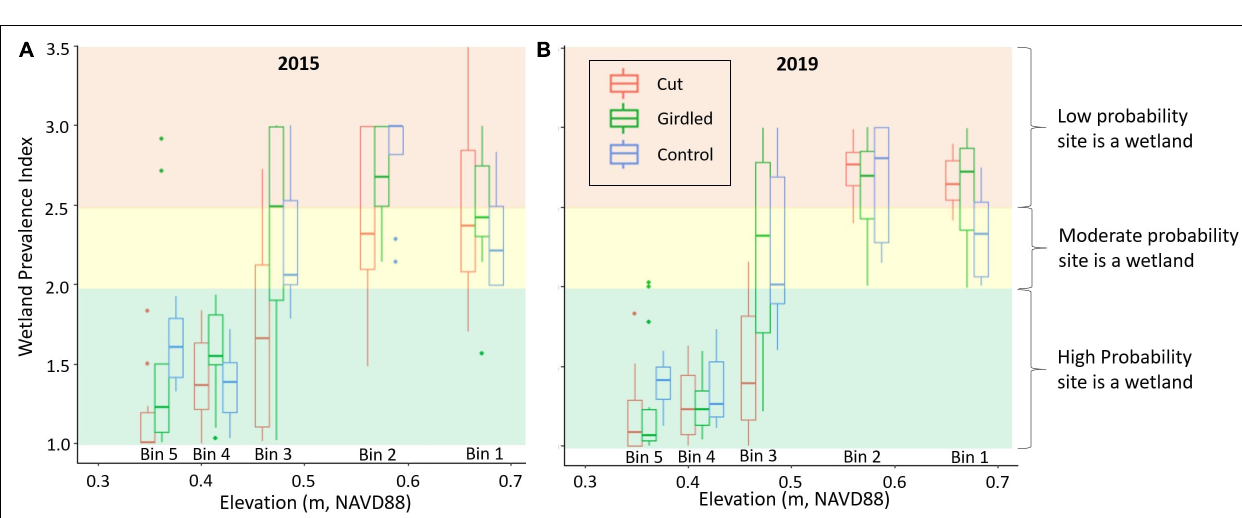
showing only the high forest, transition, and low marsh, respectively, for simplicity) and treatment (Cut on top, Girdled in middle, and Control on bottom). A value of 1 represents complete coverage of all vegetation plots, and a value of zero represents complete absence from all vegetation plots. Trend lines depict Loess-smoothed